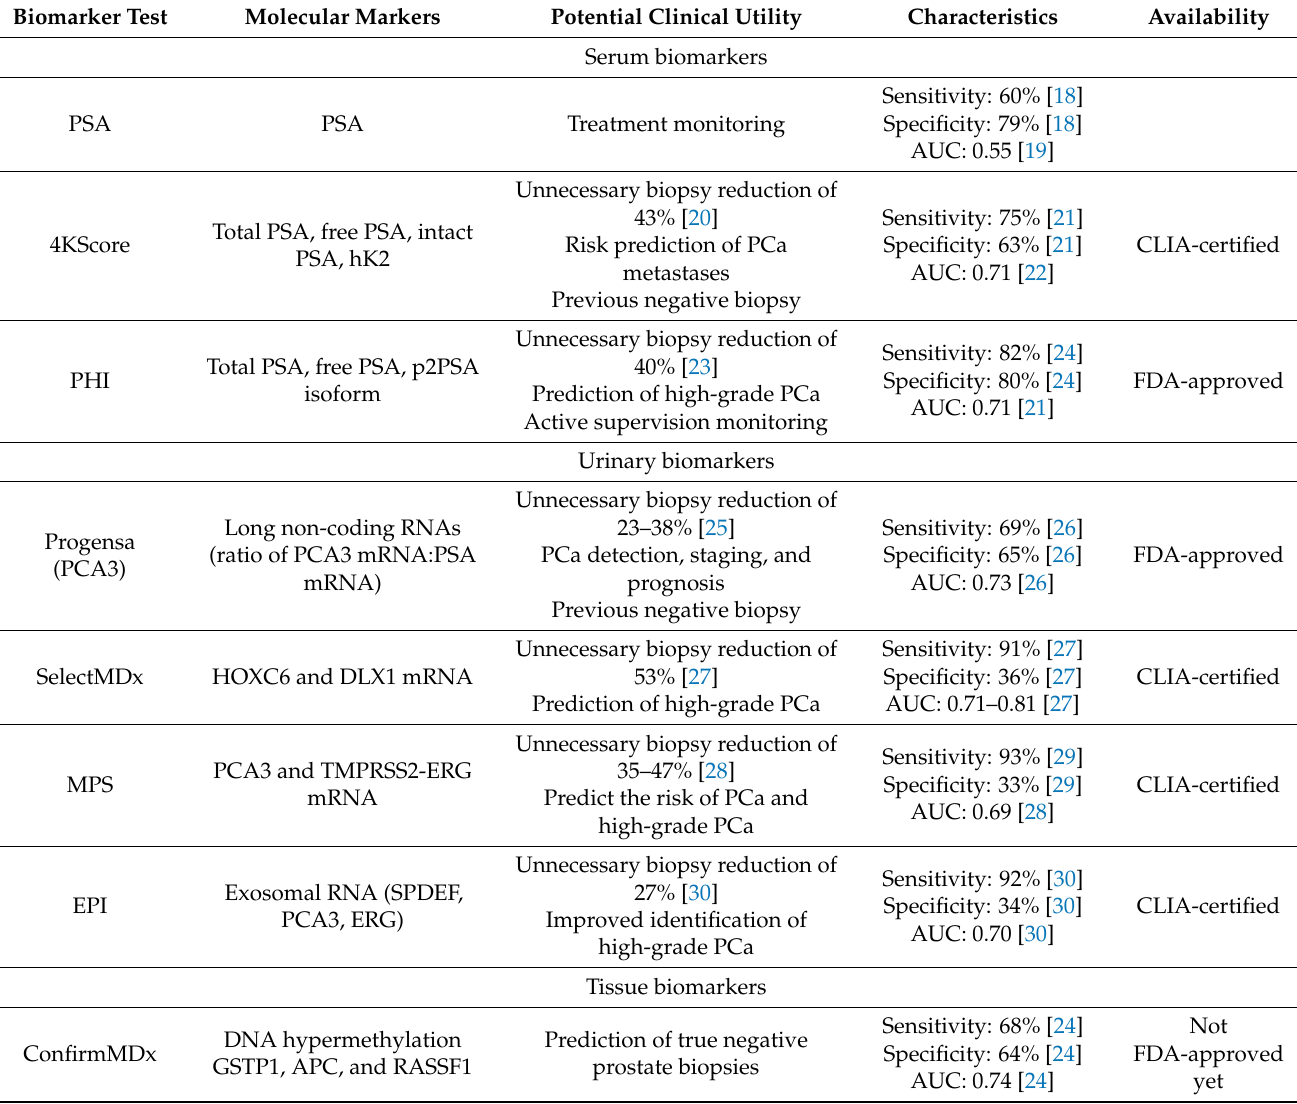
Table 1. Potential clinical utility, characteristics, and availability of prostate cancer